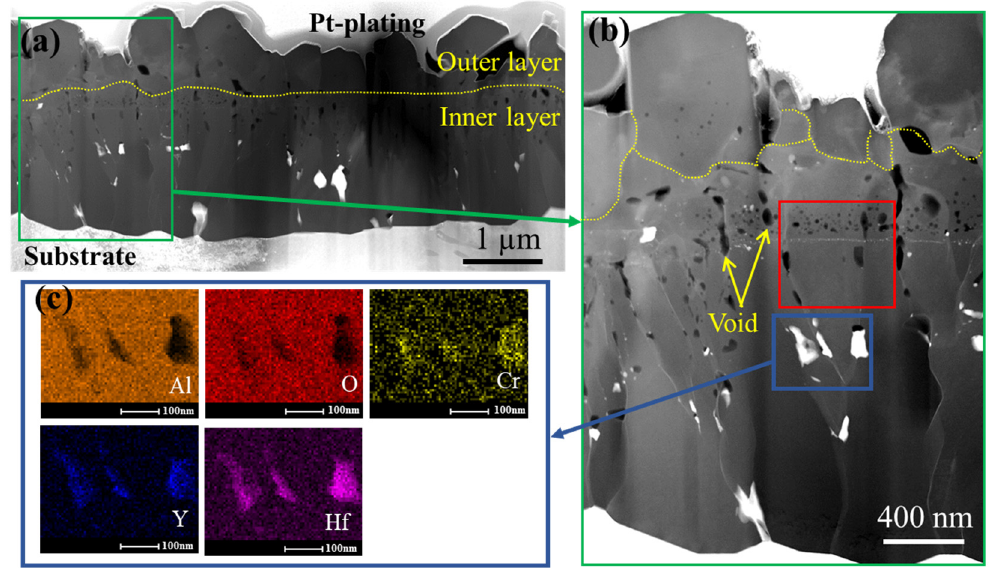
Figure 6. Morphology of the oxide scale on the NiCrAlYHf alloy (cut by FIB) after 100 h at 1100 °C in air ( a ), local enlarged image ( b ), and EDS analysis ( c ).